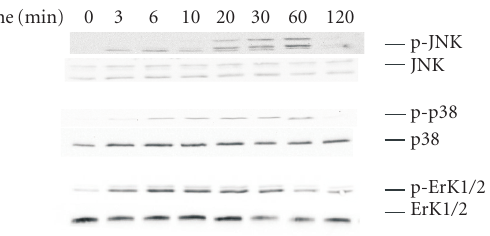
Figure 1. The e ff ects of IL-1 β on JNK, p38, and Erk1/2 MAPK activation in human T/C28a2 chondrocytes. The chondrocytes were stimulated with IL-1 β (100pg/mL). Incubations were ter- minated at the indicated time points. Two parallel immunoblots were run from same cell lysates using antibodies against the Thr- 183/Tyr-185, Thr-180/Tyr-182, and Thr-202/Tyr-204 phospho- rylated (ie, activated) JNK (p-JNK), p38 (p-p38), and Erk1/2 (p- Erk1/2) and against total JNK, p38, and Erk1/2. The experiment was repeated three times with similar results.